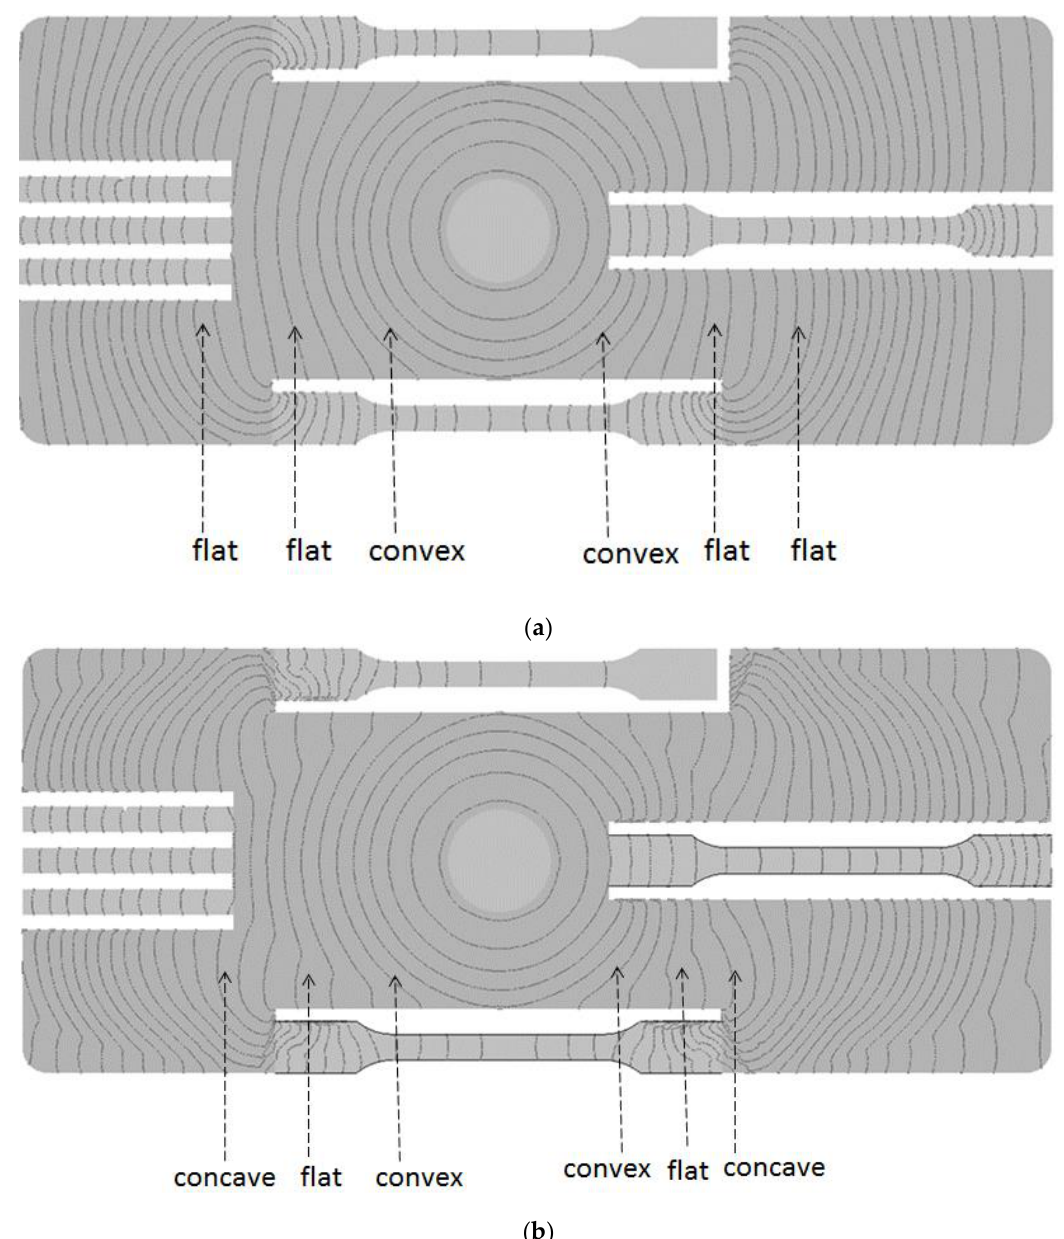
Figure 13. The melt flow front for the PP + SF composite in the injection molding simulation, ( a ) without flow–fiber coupling, ( b ) with flow–fiber